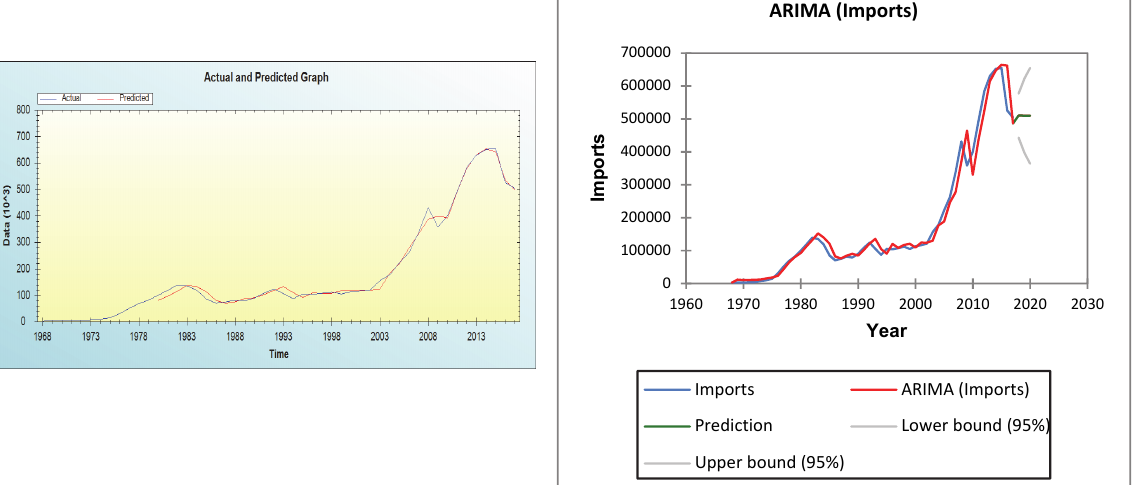
Fig. 8. Graph of Import using Neural Network Fig. 9. Graph of Import using ARIMA (1, 1, 2)